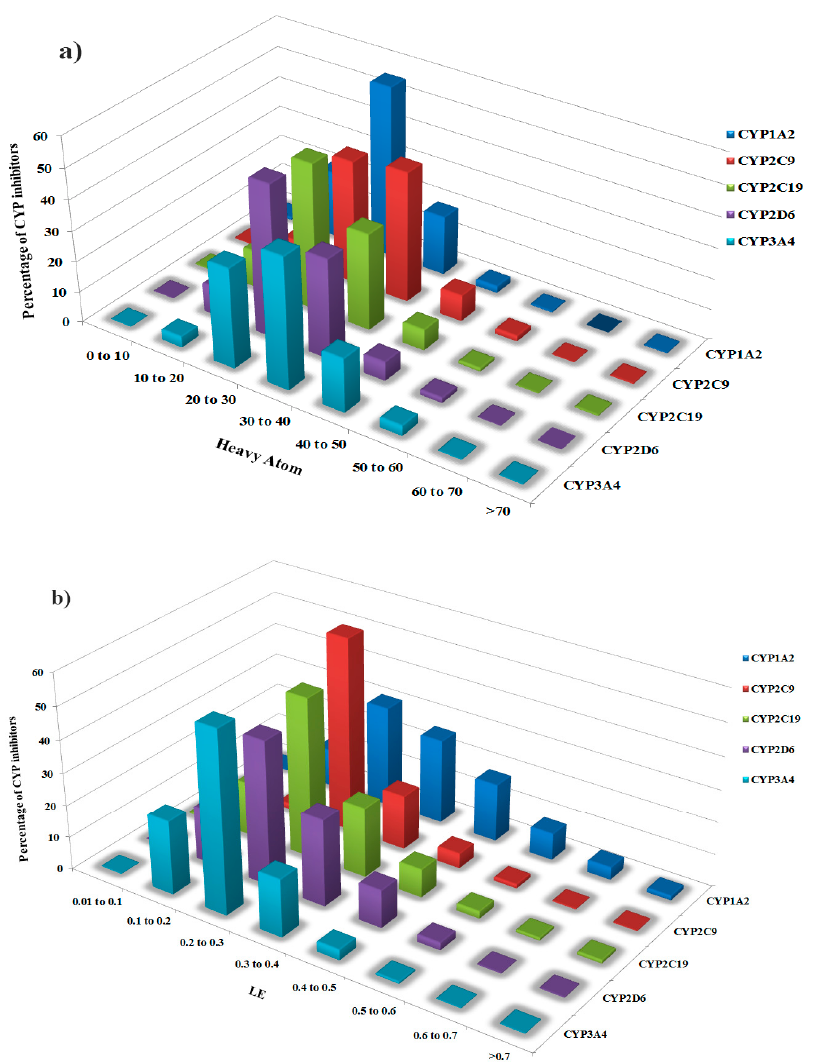
Figure 5. ( a ) Distribution of heavy atom count and ( b ) LE values for each class of cytochrome P450 inhibitors including CYP1A2, CYP2C9, CYP2C19, CYP2D6 and CYP3A4.